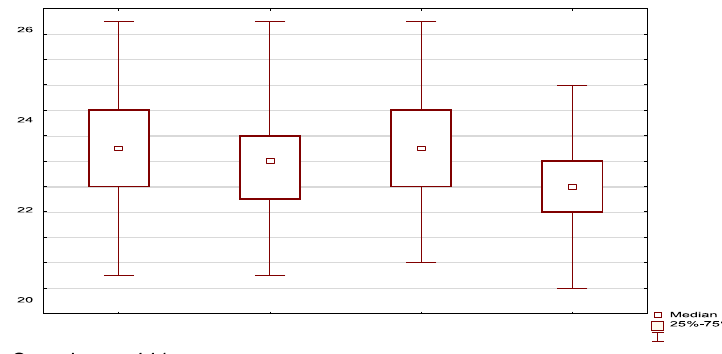
Figure 4. Distribution of results for agitation in individual populations